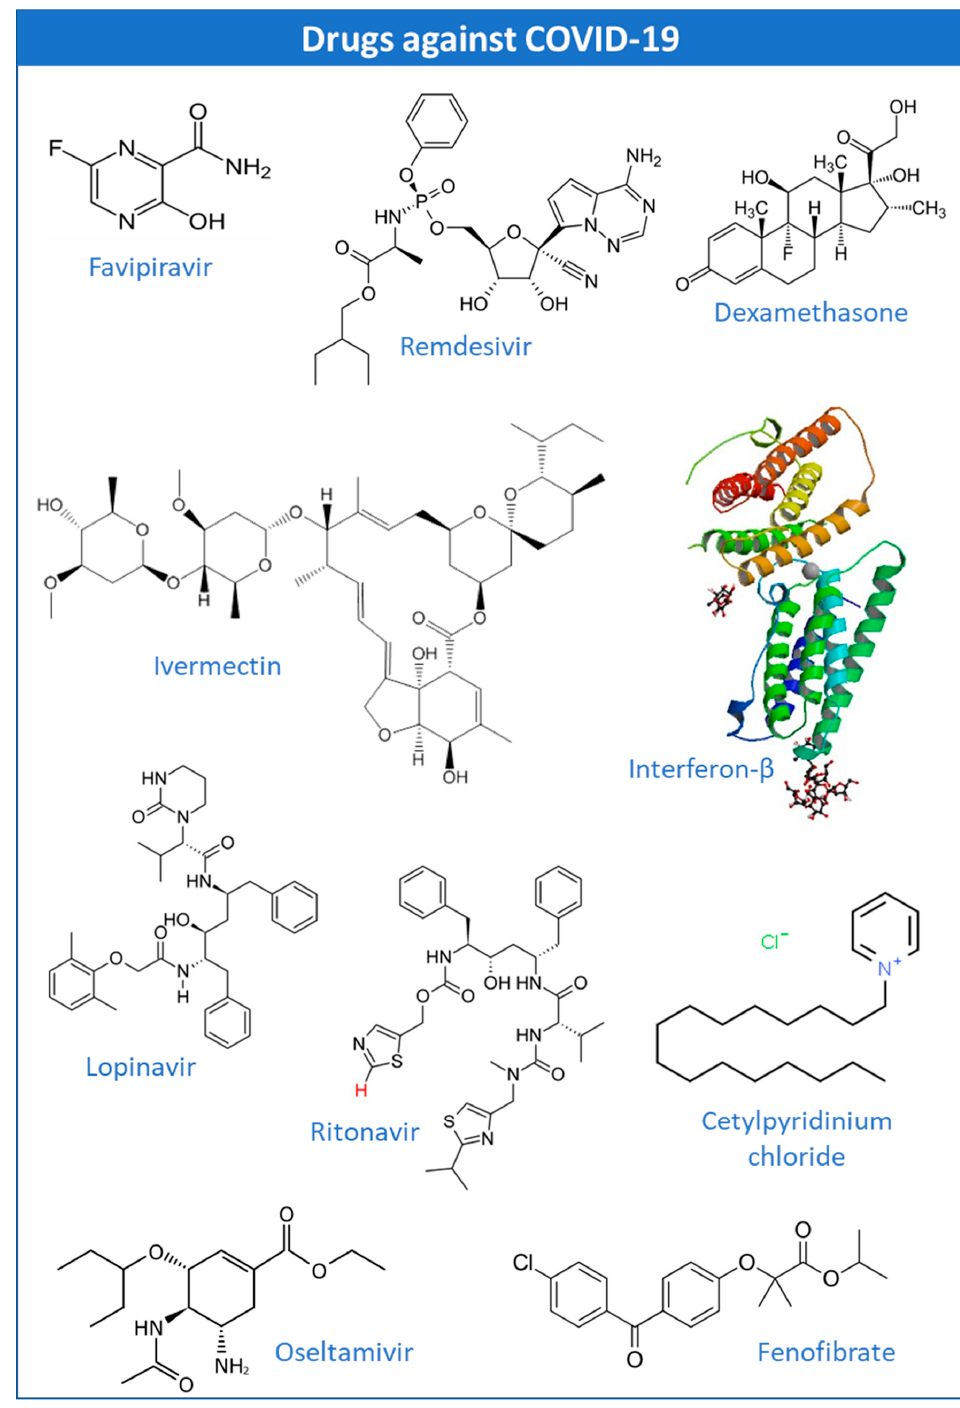
Figure 5. Structures of some drugs applied in clinical practice or clinical trials against